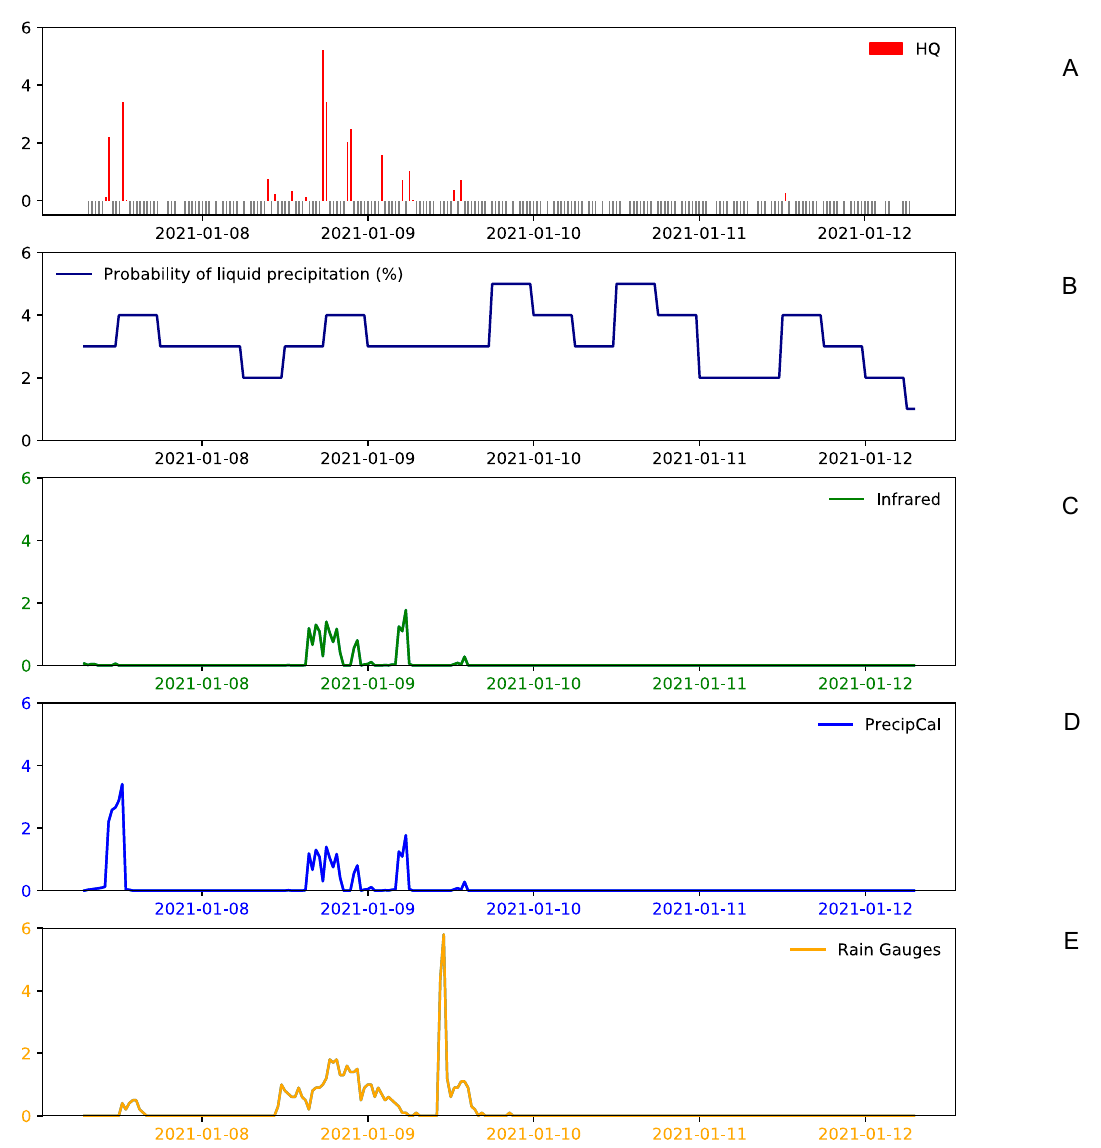
Figure 6. The evolution of the precipitation associated with storm Filomena every 30 min at the Retiro Park meteorological station, Madrid (Latitude: 40°24 ′ 43 ″ N, Longitude: 3°40 ′ 41 ″ W, Altitude 667 m, panel E) and the estimations by the IMERG-Late algorithm (High-Quality (HQ), Infrared and Calibrate Precipitation (PrecipCal) products). Units are mm/hr. High-quality data ( A ) is discontinuous, so bar graphs are used. Grey marks in A indicate no data. Original rain gauge data from AEMET. IMERG data were processed using UCLM’s Fortran programs and NCL and Python scripts from the original Level-2 PPS files ( B – E ).